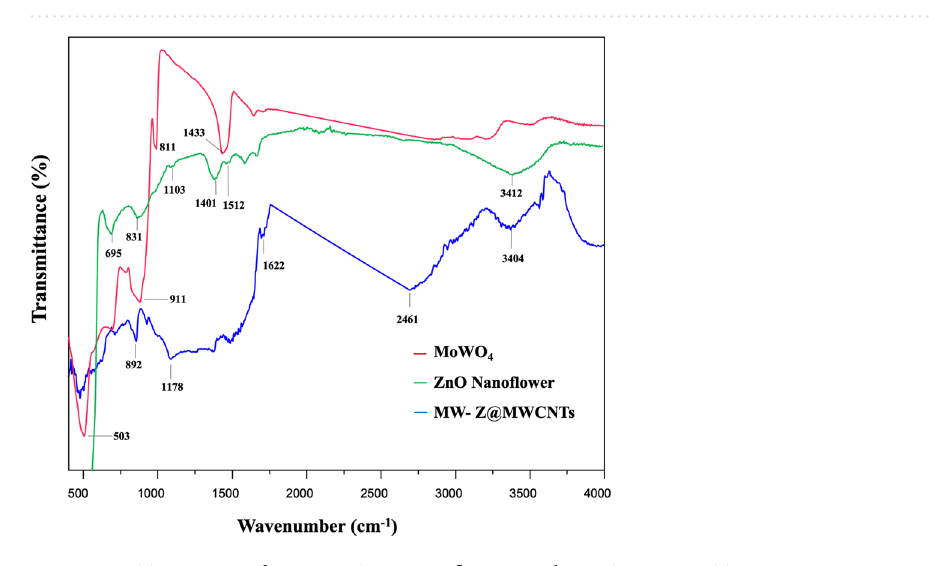
Figure 5. FTIR spectra of MoWO4, ZnO nanoflowers, and